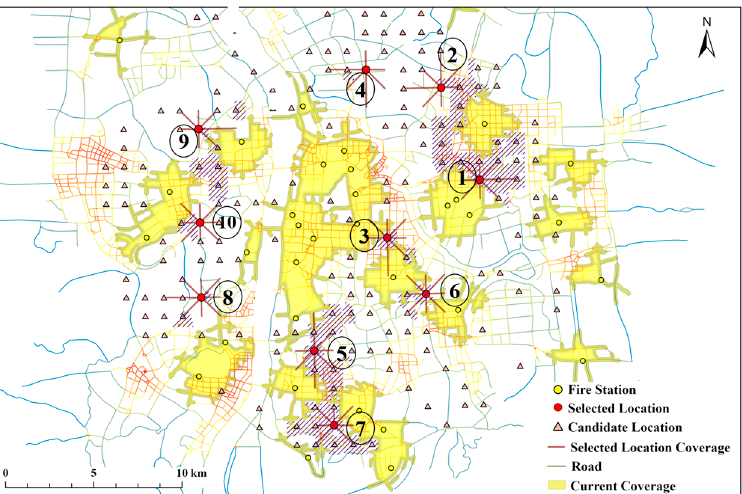
Figure 7. Map showing extension of the location of a fire station from a specific site to a region using the weighting of emergency service data (purple shaded areas are the optimum areas for new fire stations; the closer a new fire station is to a selected location, the better).